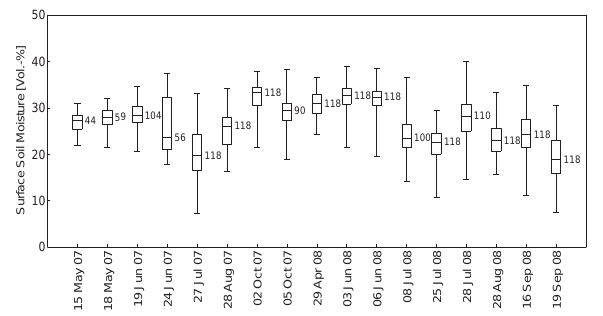
Figure 3. Box-Whisker-Plot for the arable test site of all dates of measurements; the bottom and top of the box show the lower and upper quartiles, the band near the middle of the box is the median, the ends of the whiskers represent the measured minimum and maximum surface soil moisture; the number to the right of each box indicates the number of sampling locations for each date; data sets without gaps (n = 118) were used for the EOF analysis.